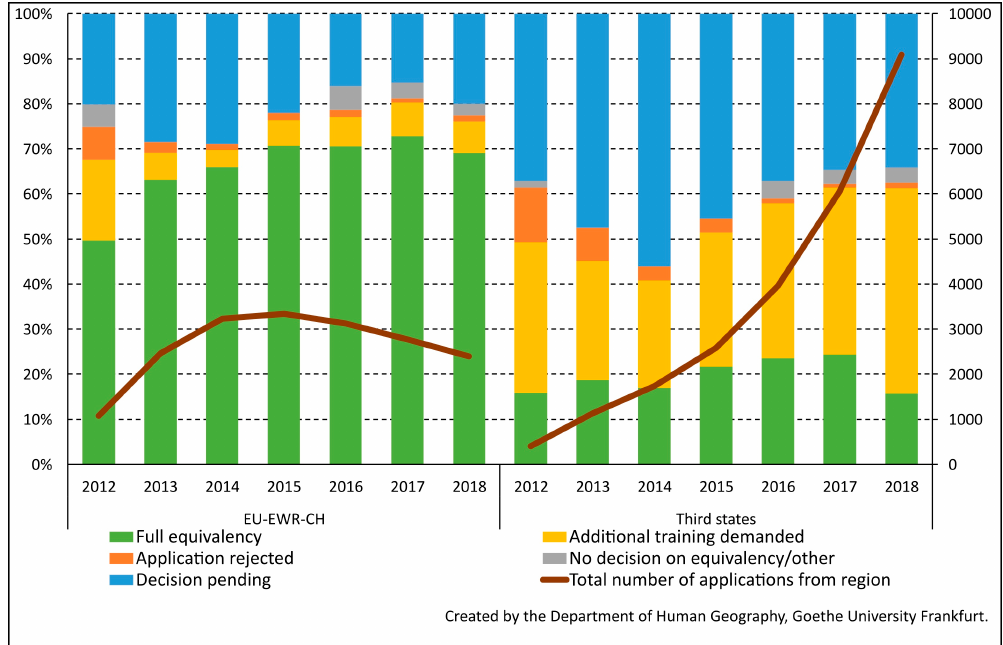
Figure 3. Decisions issued in new credential recognition procedures for registered nurses and total number of applications by region of origin, 2012–2018.